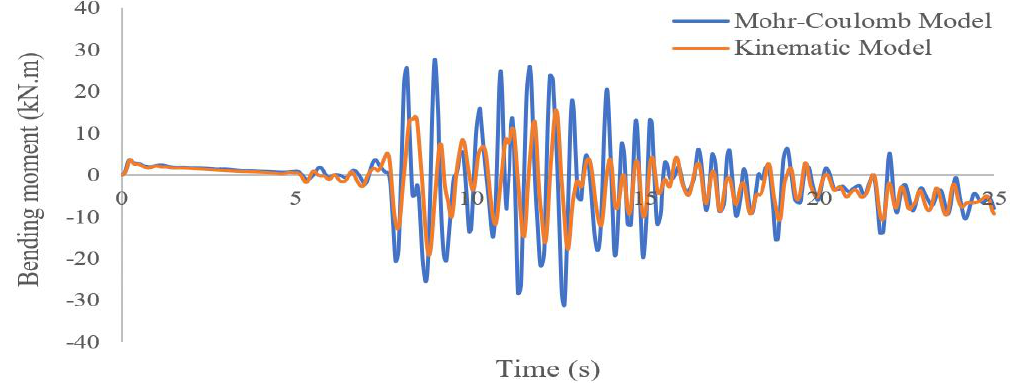
Figure 18. Bending moment during the earthquake loading on the top of the circular tunnel lining.